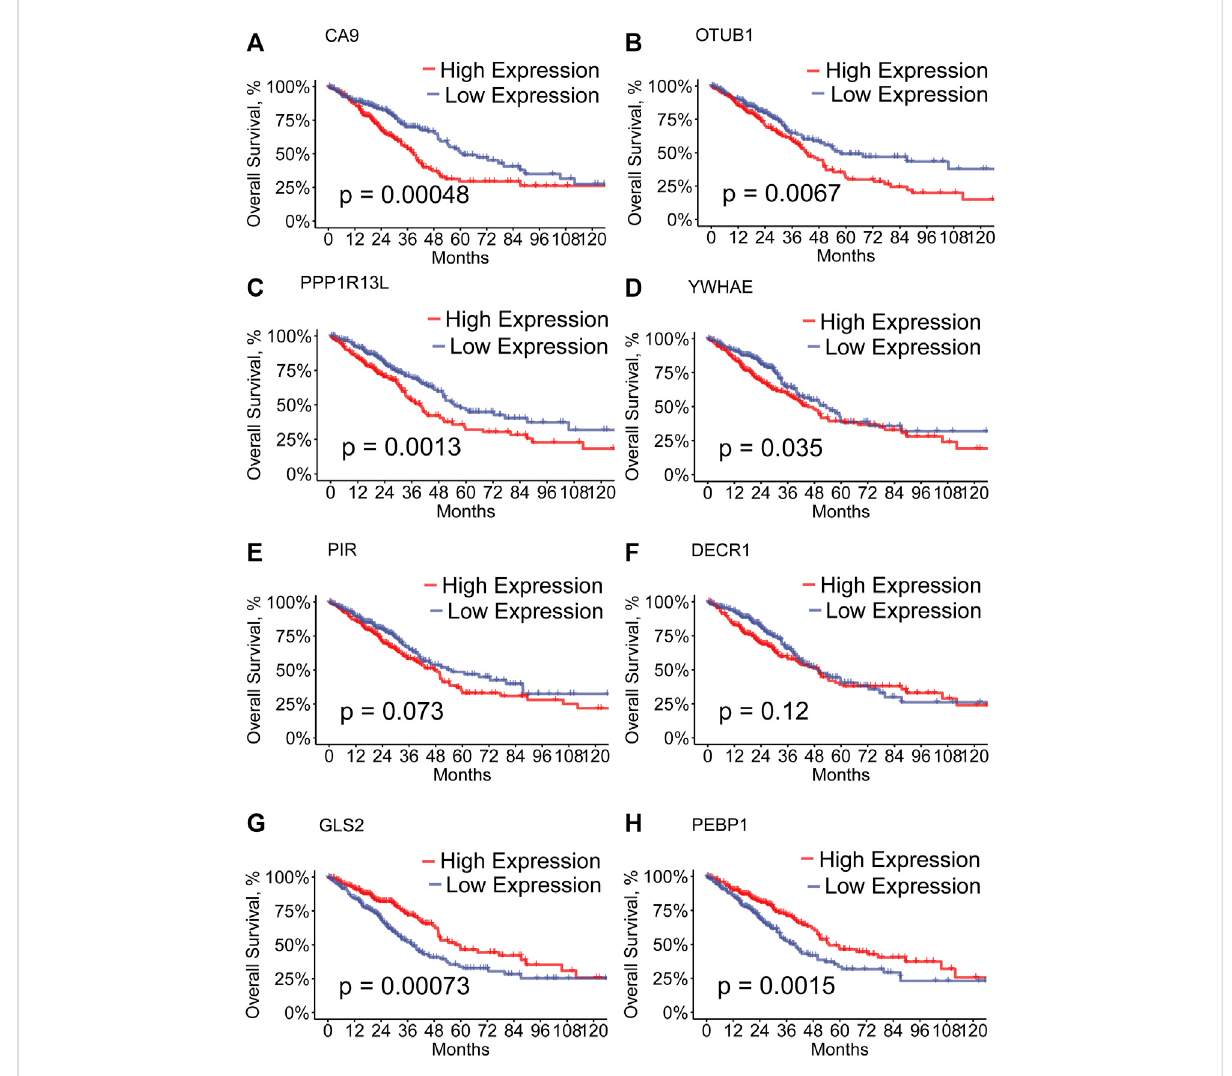
FIGURE 2 (A – H) Kaplan – Meier curves of high- and low-expression of the hub genes of LUAD patients in the